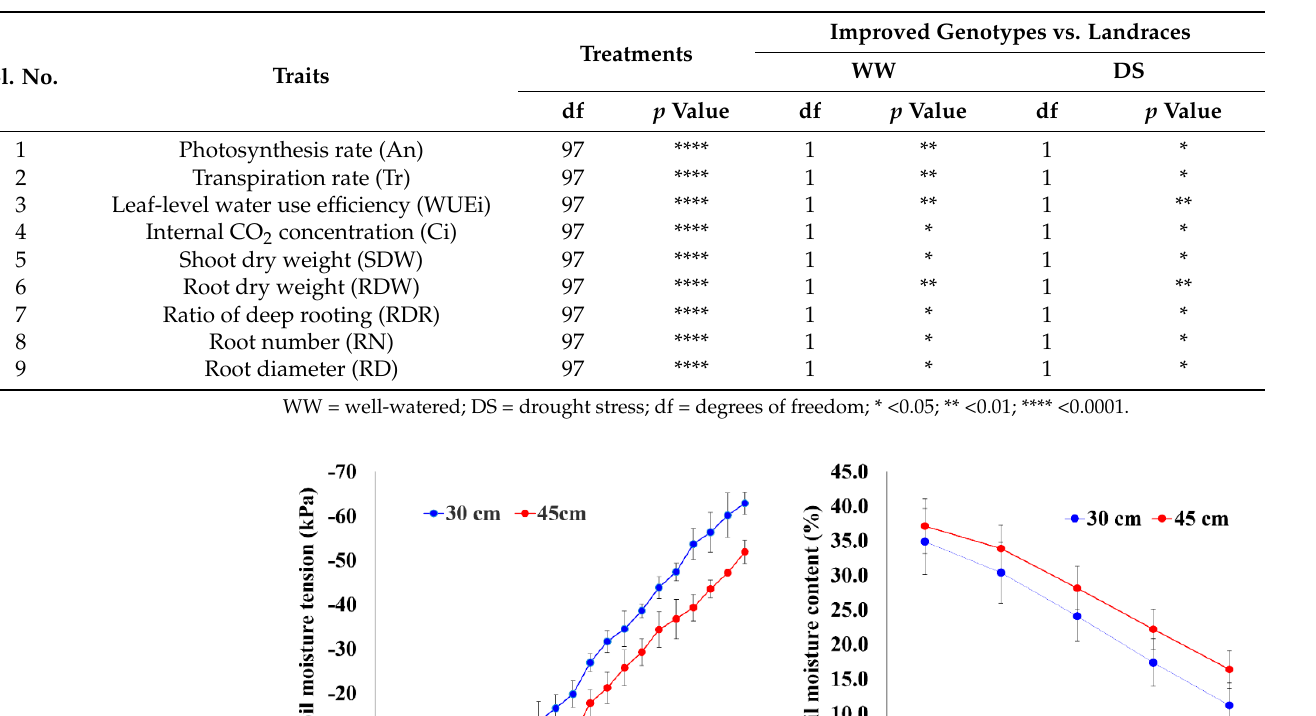
Table 1. Overall significant difference level (t-test) between treatments and improved genotypes vs landraces for the studied traits.